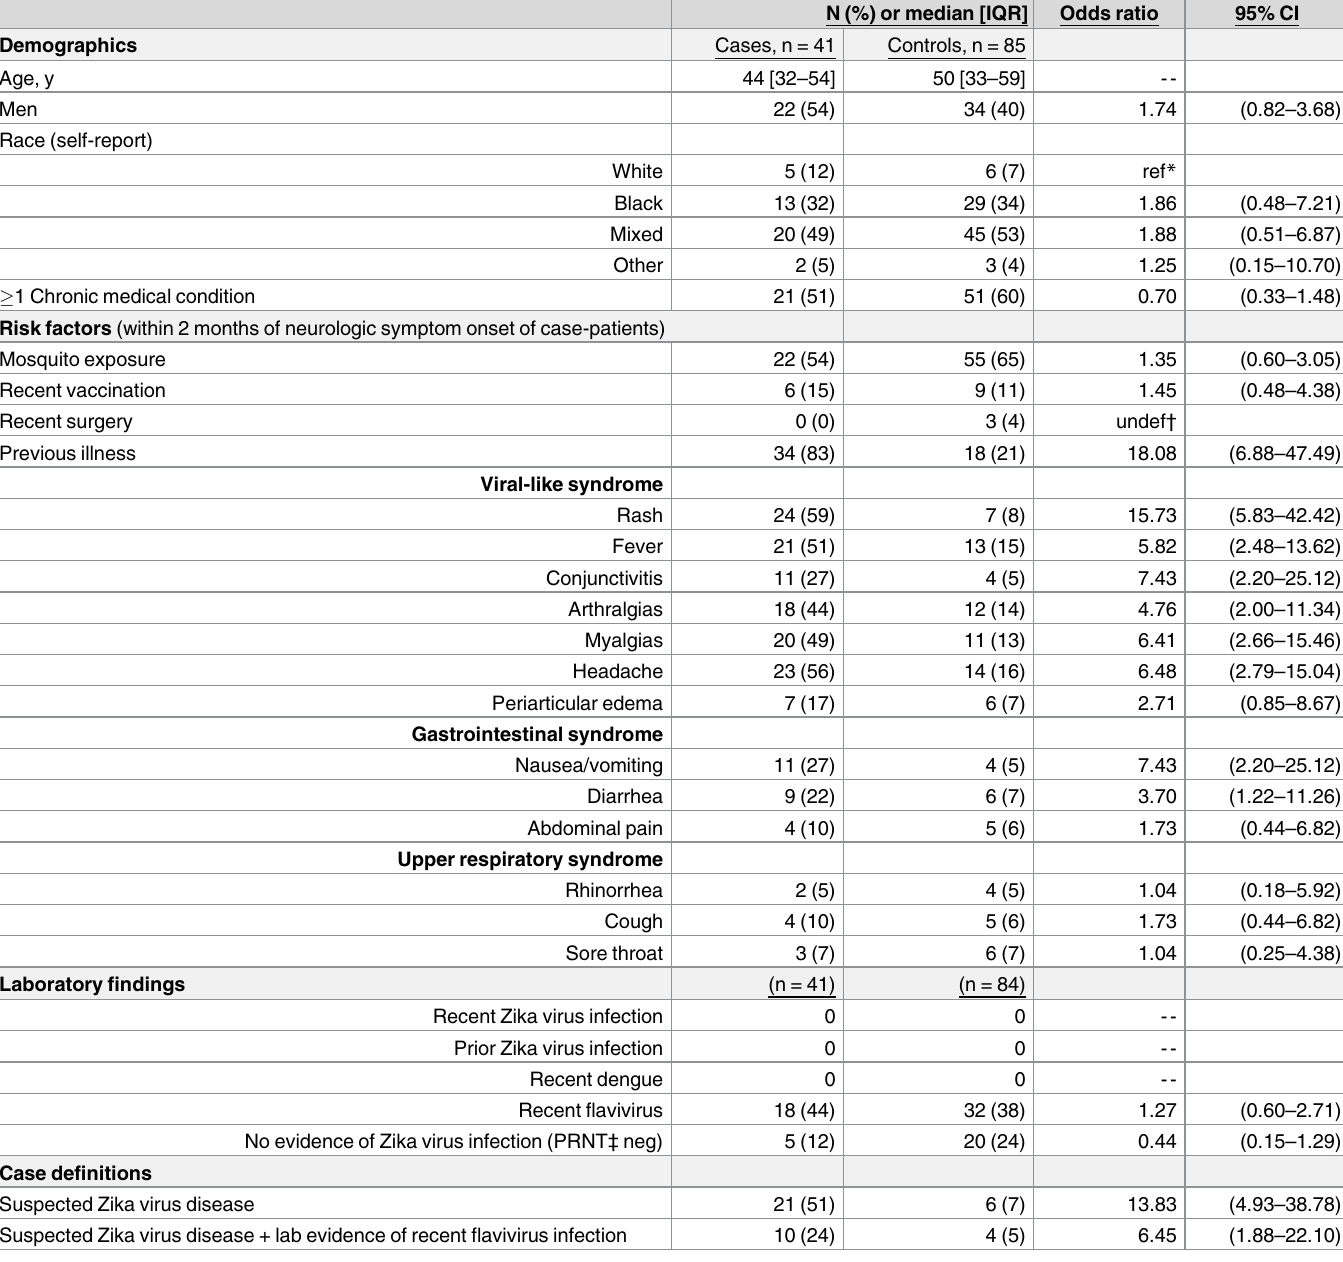
Table 3. Demographics and risk factors of case-patients with Guillain-Barre´ syndrome and controls enrolled in the case-control investigation, Sal- vador metropolitan area, Brazil,